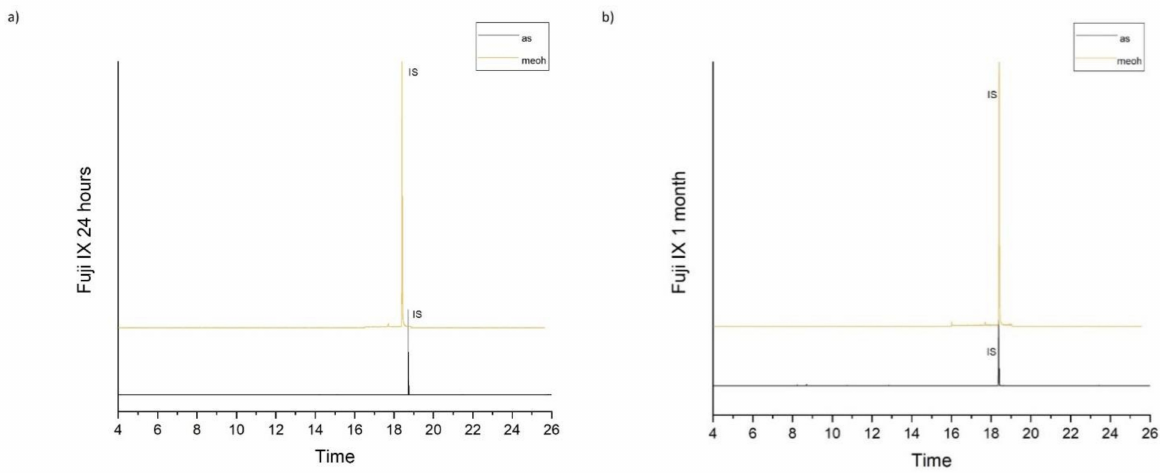
Figure 5. ( a , b ). Chromatograms of Fuji IX in artificial saliva and methanol for both observation periods (24 h and 1